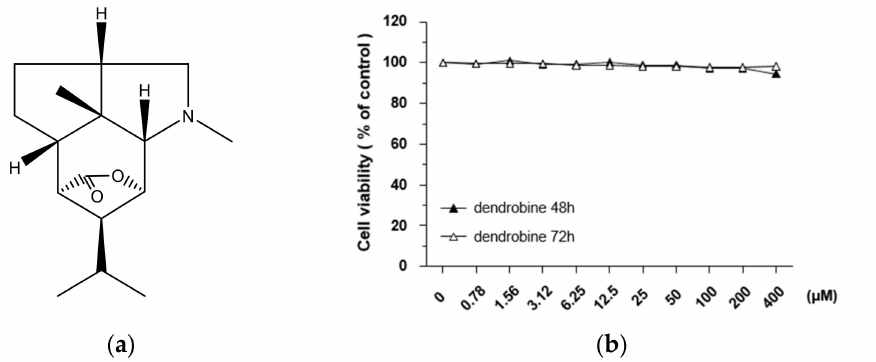
Figure 1. Effect of dendrobine on the viability of A549 lung cancer cells. ( a ) Chemical structure of dendrobine extracted from Dendrobium nobile . ( b ) Cell viability was measured using a Cell Counting Kit-8 assay kit after treatment with the indicated concentration of dendrobine for 48 or 72 h. Values are expressed as the mean ± SD of three independent